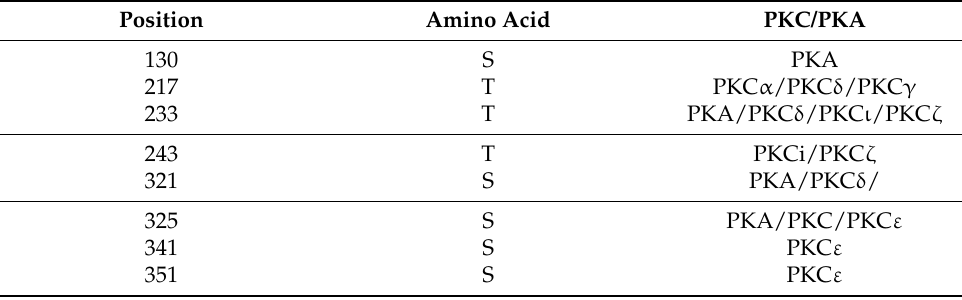
Table 2. In silico prediction of PKC and PKA phosphorylated LPA 3